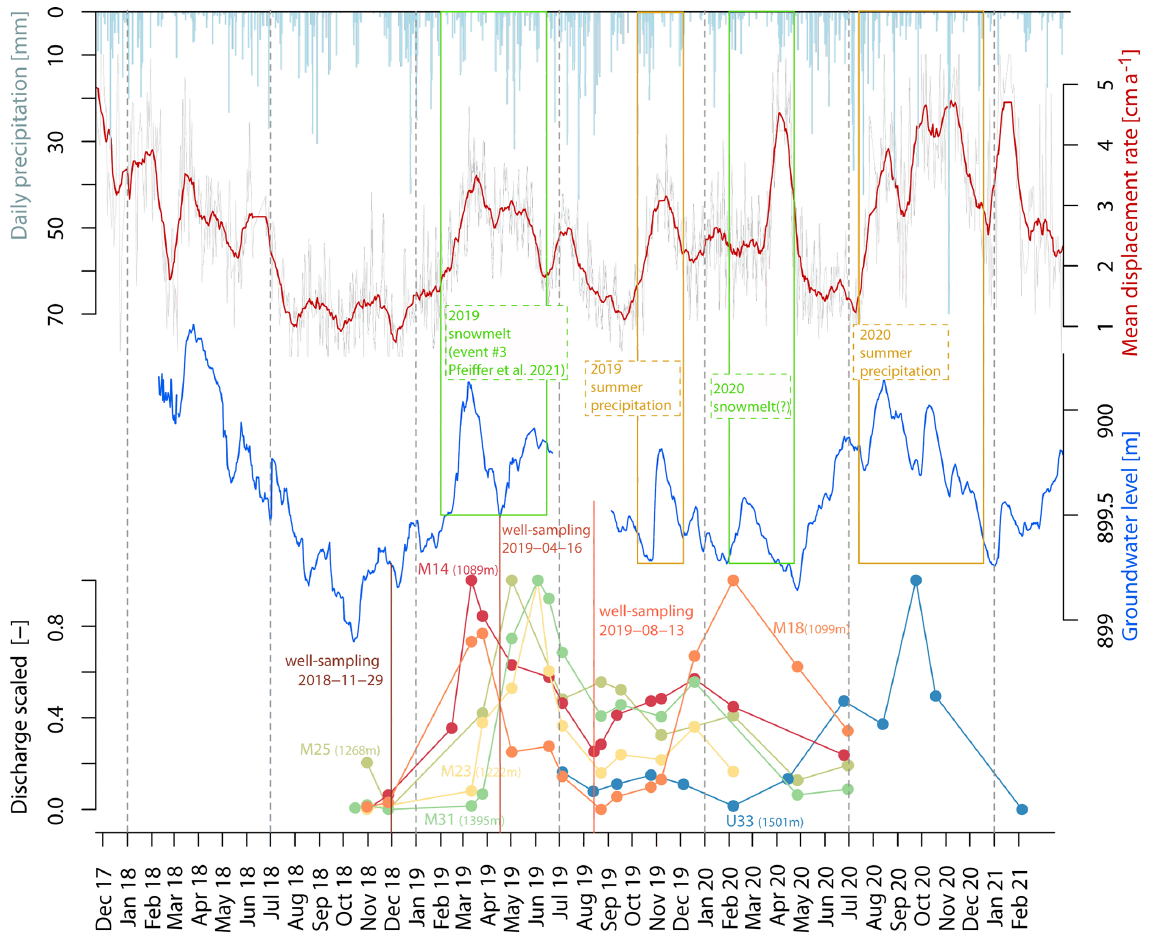
Figure 6. Time series of daily precipitation at Patscherkofel (source: ZAMG), mean displacement rate (source: Federal State of Tyrol), groundwater level in well KB1 (source: Austrian Service for Torrent and Avalanche Control), and discharge of selected housed springs. Discharge was scaled between 0 and 1 for better comparability of the different